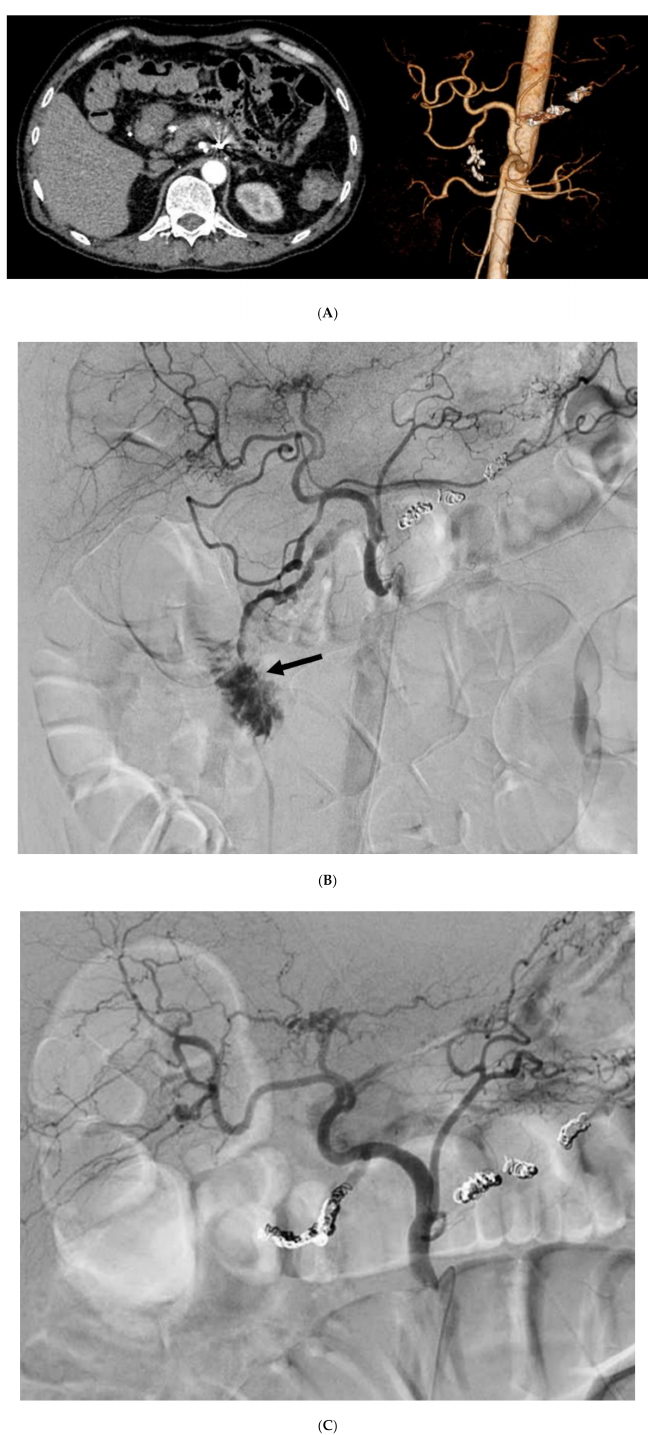
Figure 1. Transcatheter arterial embolization with coils. Angiographic images of a 55-year-old man with chronic pancreatitis. The patient had melena and endoscopic hemostasis was attempted, but the bleeding could not be stopped. ( A ) Contrast-enhanced CT was performed but a pseudoaneurysm was unclear by contrast-enhanced and three-dimensional CT. ( B ) The celiac axis angiogram revealed extravasation (indicated by the arrow) from the gastroduodenal artery. A microcatheter could be inserted into the artery over the pseudoaneurysm, and coils were placed between the distal and proximal sites of hemorrhage. ( C ) After embolization with a coil, hemostasis was obtained. The patient had no signs of recurrent bleeding or complications after transcatheter arterial